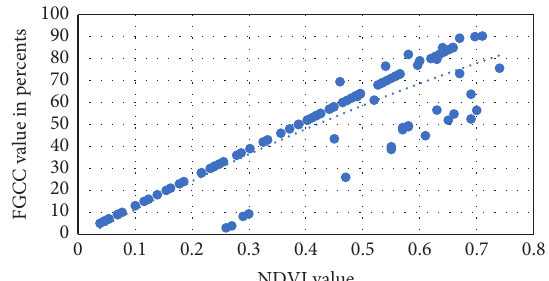
Figure 10: Approximation of the polynomial model for NDVI into FGCC conversion for winter